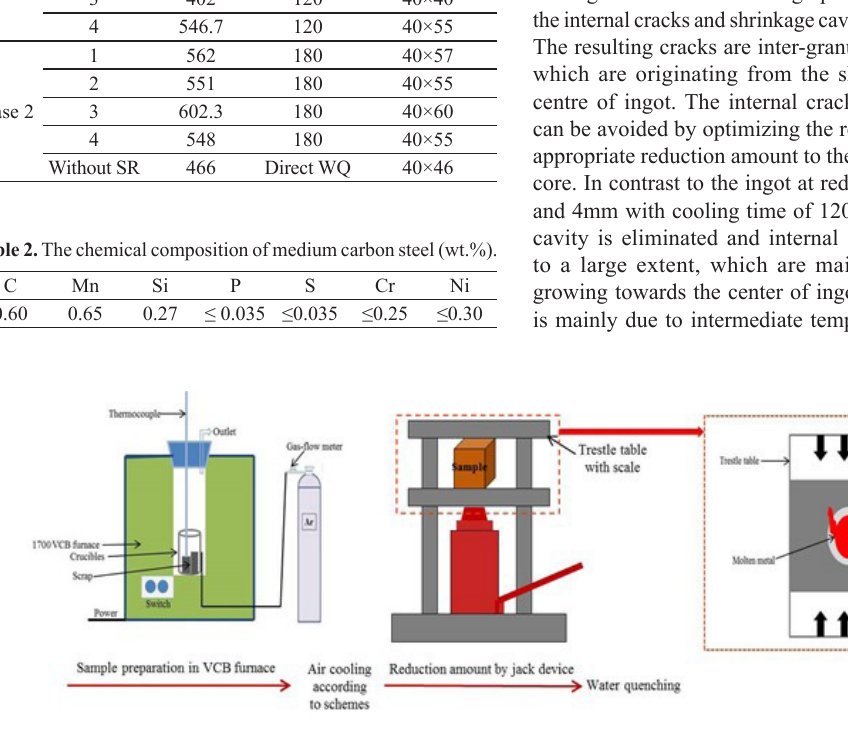
Figure 1. The physical model diagram of the experimental setup.